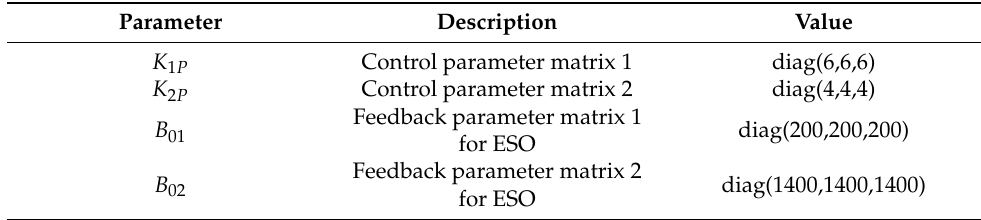
Table 2. Controller